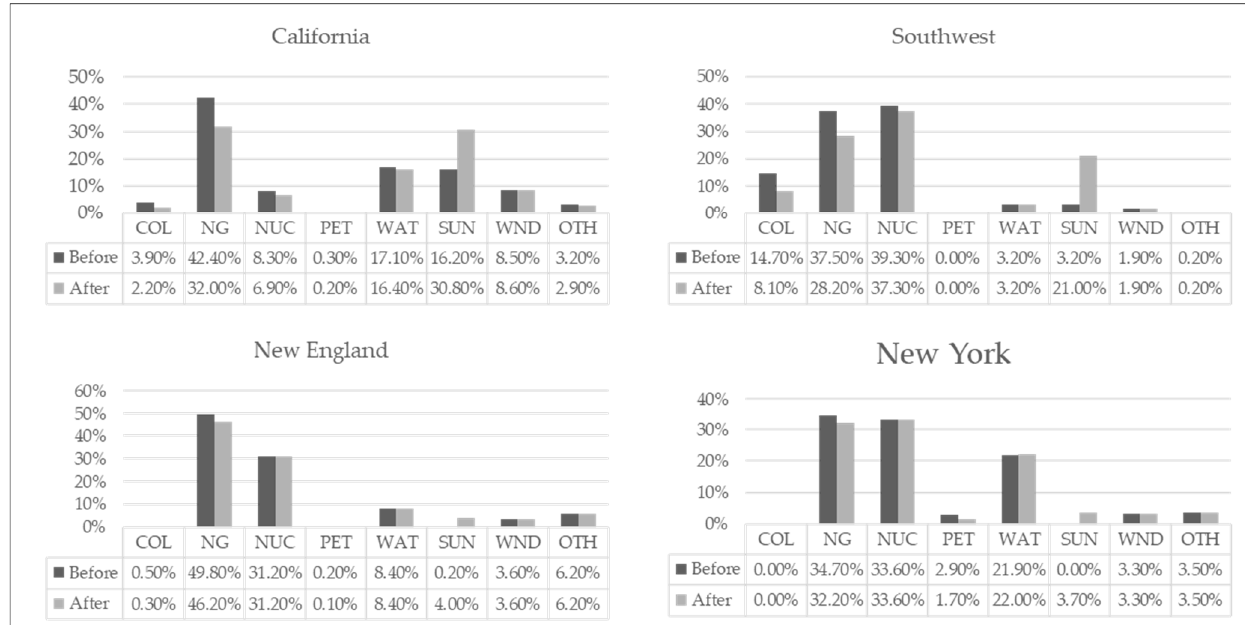
Figure 1. 100% Solar Penetration by region before and after.